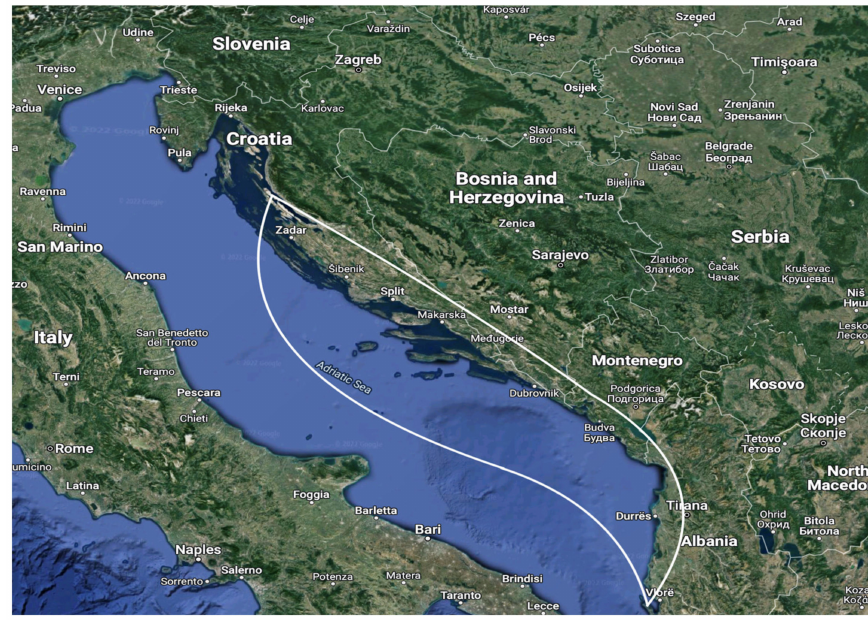
while Albanian cruising destinations have not been recognized by the market yet.